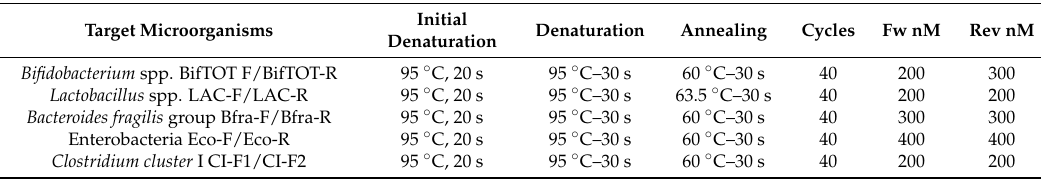
Table 2. qPCR amplification protocols and primer